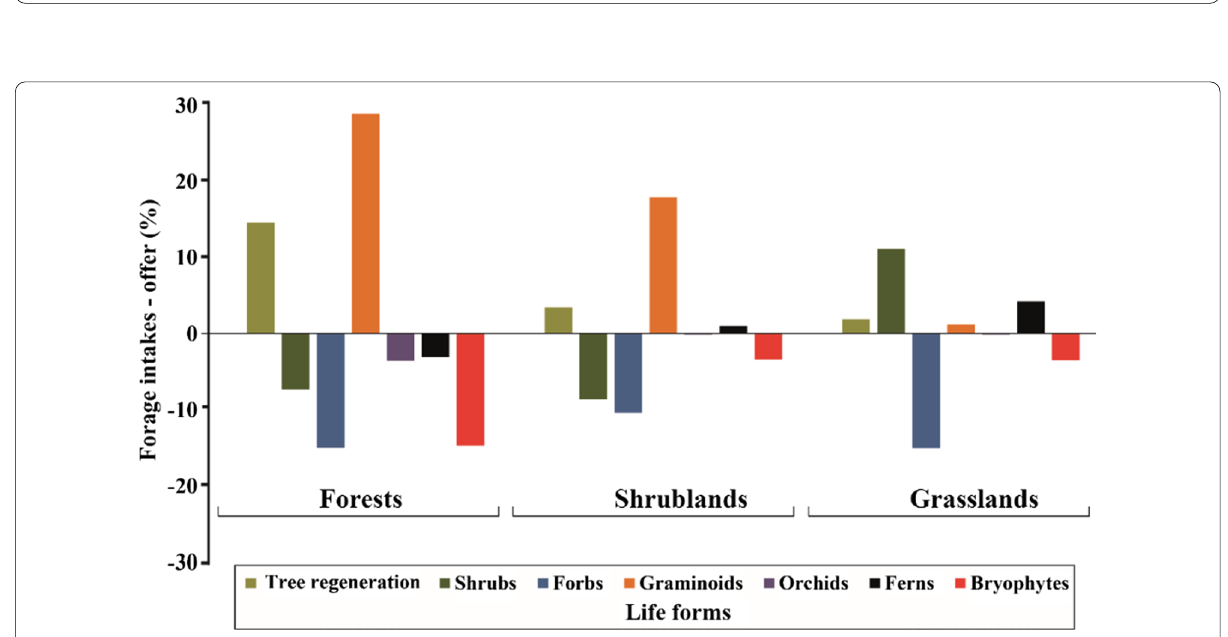
Fig. 6 Difference between forage rabbit intakes and offer, by life forms at the studied vegetation types (forest, shrublands, and grasslands). Negative responses indicated that rabbits avoid it (e.g., less intakes than offer), while a positive response indicated that rabbits prefer it (e.g., more intakes than